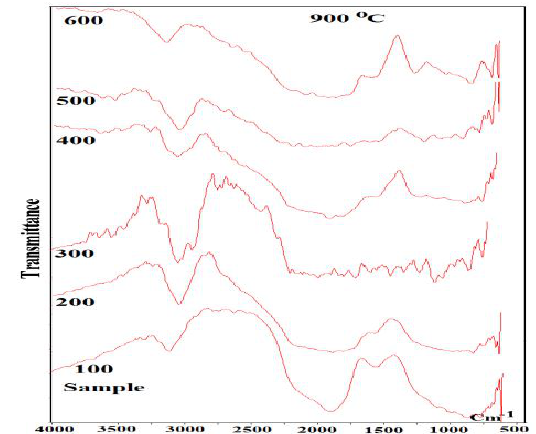
Fig. 8. FT-IR spectra of the mixed oxide at the same calcination temperatures and different TiO2 contents. The sample number labeled in figures. Are introduced in table.